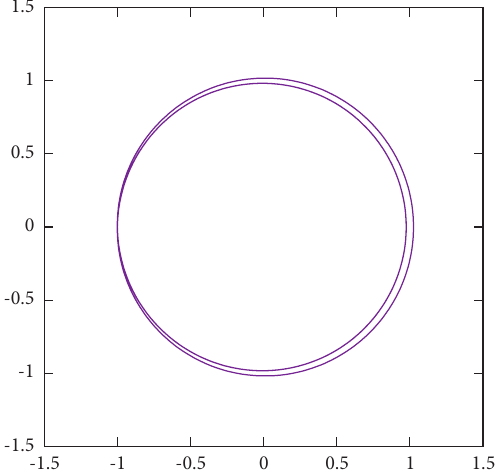
Figure 12: Curve in the Example 9.